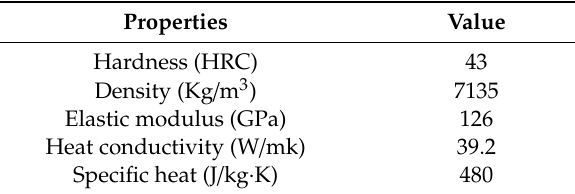
Table 2. Mechanical properties of gray cast iron.